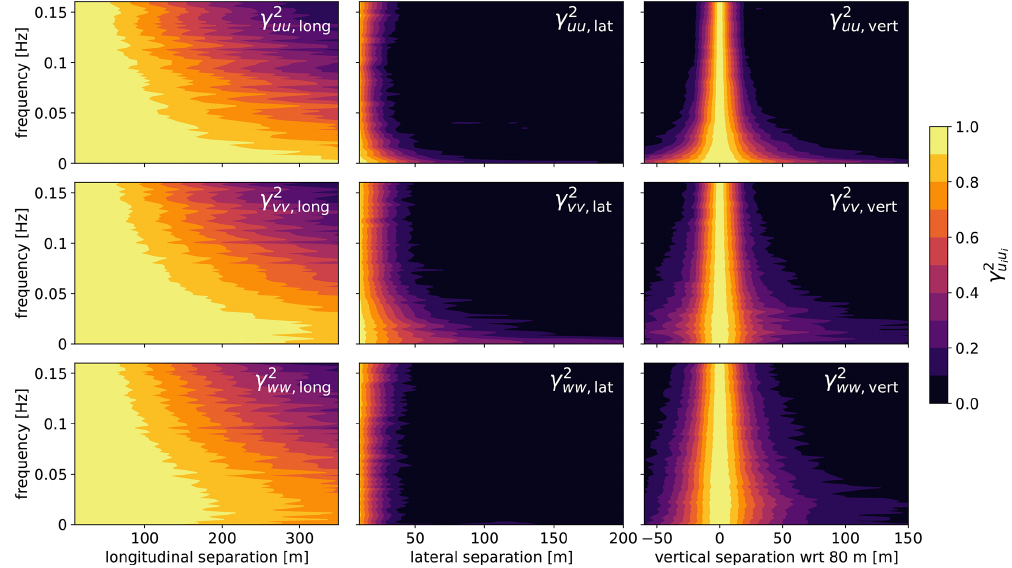
Figure 14. Contour of the coherence for all components of the turbulence, along all three separation directions, over a continuous range of separation distances. The diagonal panes are the component in the same direction of the separation.